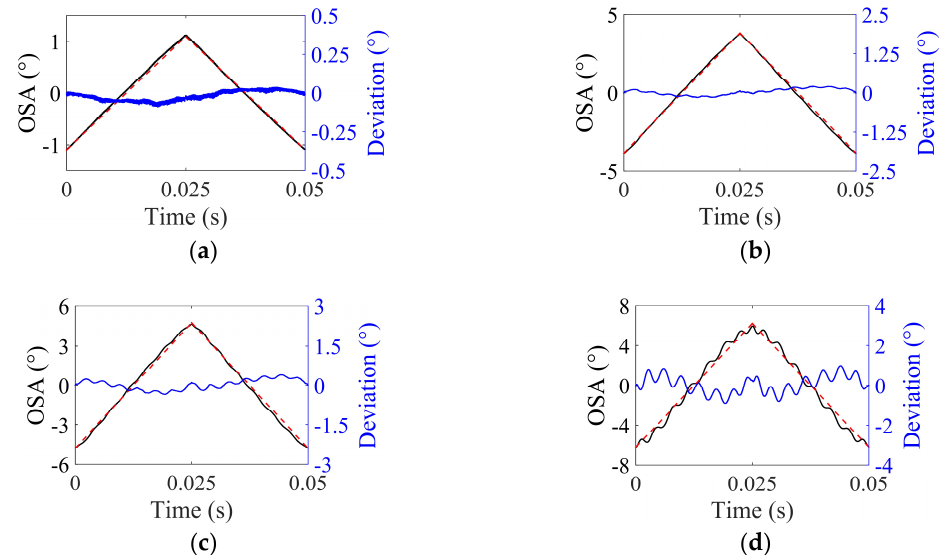
Figure 8. Performance of the ISETF with respect to the driving voltage, V d (driving frequency: 20 Hz, sampling rate: 50 kHz): ( a ) V d = 10 V, ( b ) V d = 35 V, ( c ) V d = 45 V, and ( d ) V d = 65 V (scan output using ISETF: solid line in black; ideal triangular output: dashed lines in red).